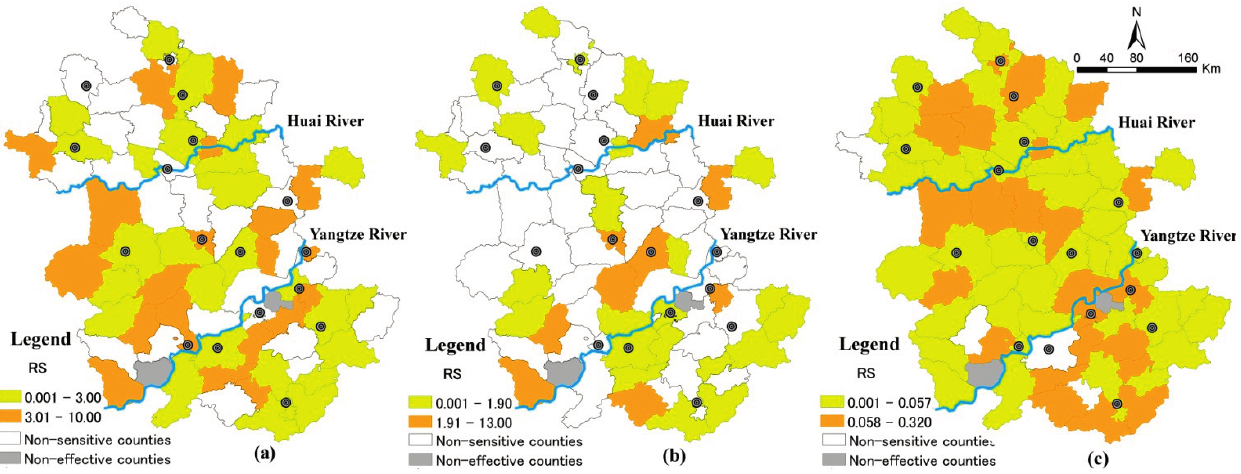
Figure 4. The spatial distribution of RS for HFM in Anhui Province: ( a ) RS to temperature; ( b ) RS to precipitation; ( c ) RS to absolute